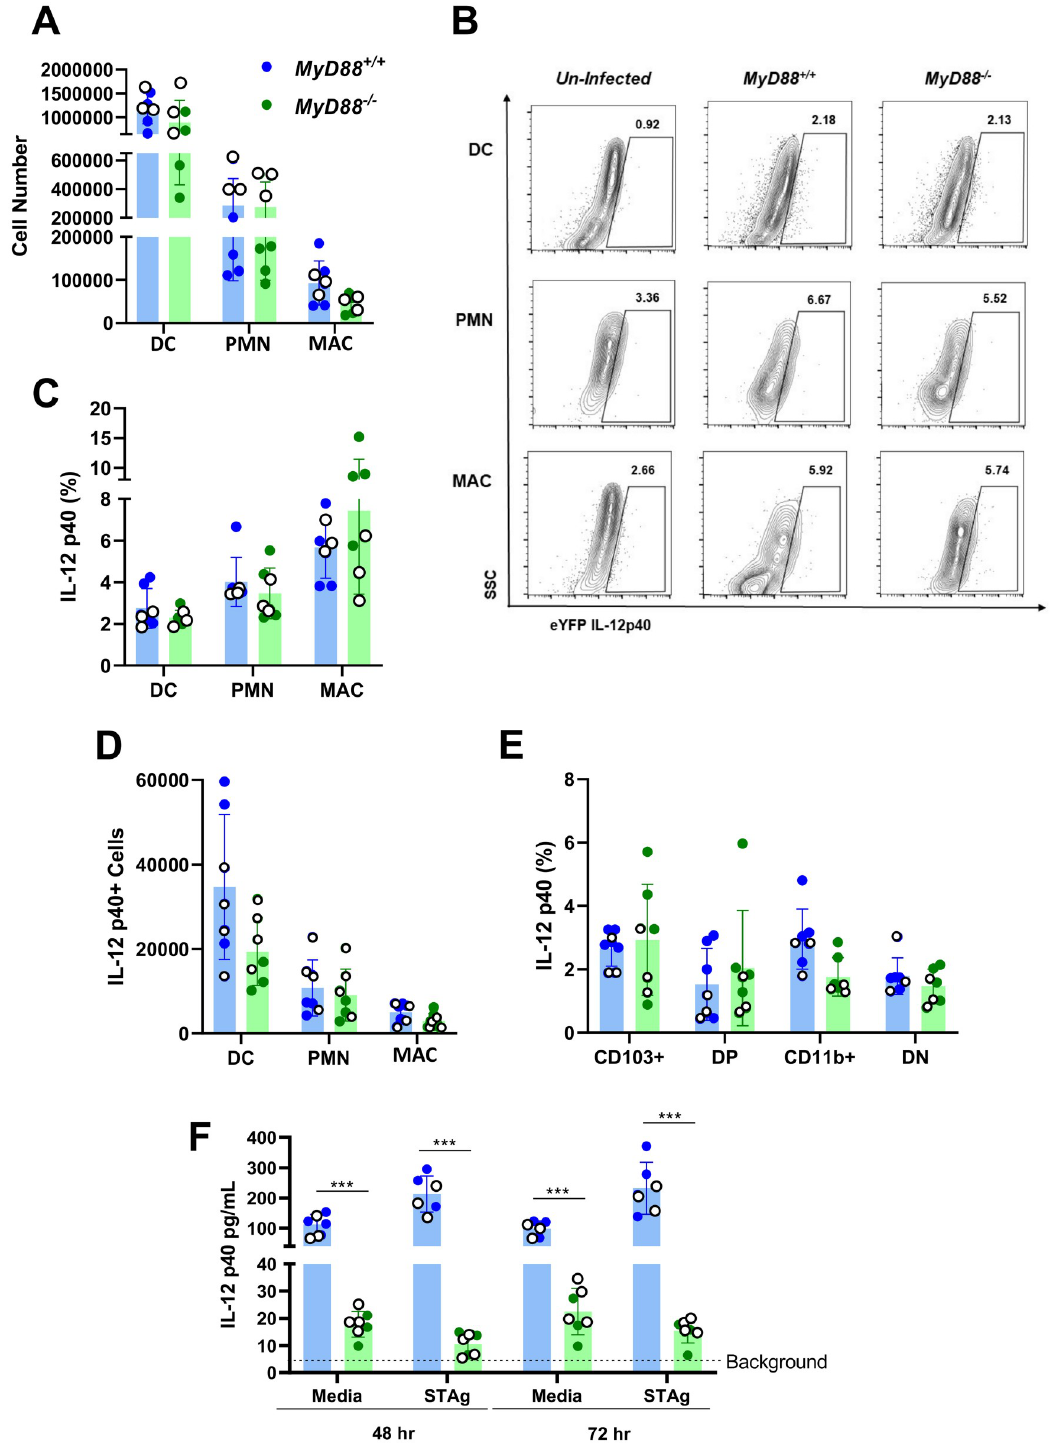
Fig 2. Lamina propria dendritic cells, neutrophils, and macrophages produce IL-12p40 in the absence of MyD88 during T . gondii infection. MyD88 +/+ and MyD88 -/- IL-12p40 eYFP mice were orally inoculated with 40 ME49 cysts. At day 7 post-infection, small intestinal LP cells were collected for analysis. (A) Dendritic cell (DC; MHCII + CD11c + F4/80 - ), neutrophil (PMN; Ly6G + ), and macrophage (MAC; F4/80 + ) cell numbers as determined by flow cytometry. (B) IL-12p40 expression in myeloid subsets from IL-12p40 reporter mice on MyD88 +/+ and MyD88 -/- backgrounds. Un-infected shows background levels in a representative